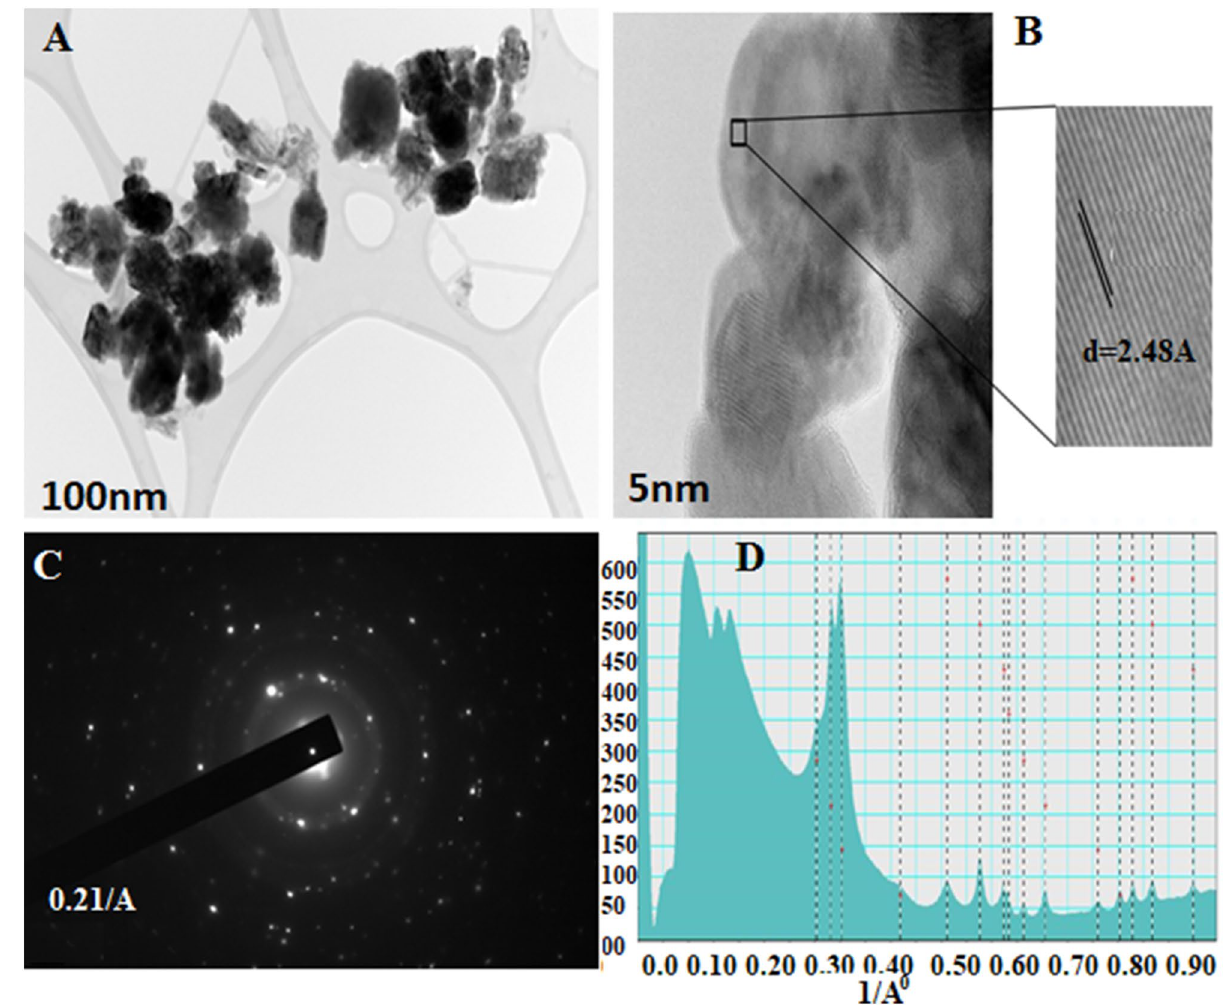
Figure 3. ( A ) Transmission electron microscopic and ( B ) High resolution-TEM images of ZnO NPs, ( C ) Selected area electron-diffraction outline of ZnO NPs, ( D ) Rotational average profile of Ω, Fig. 6(1B)). The decrease in R ct value confirms that the ZnO-NPs present in the composite improves the charge transfer characteristics of GN:ZnO NC modified GCE 42 . CC was applied to determine the electrochemi- cally active surface area of the GN and GN:ZnO NC modified electrodes by using Anson charge-time depend- ence equation Q = nFACD 1/2 π −1/2 t 1/2 , where ‘Q’ is charge in coulombs, ‘n’ number of electrons involved in redox reaction is 1 for K 3 [Fe(CN) 6 ] system, ’F’ Faraday Constant (96,485 Cmol −1 ), ‘A’ area of electrode in cm −2 , ‘C’ concentration of K 3 [Fe(CN) 6 ] (1 mM), ‘D’ diffusion coefficient is 7.6 × 10 −6 cm 2 s −1 for K 3 [Fe(CN) 6 ] and ’t’ is time in seconds [30]. The slope obtained from the plot of Q against t 1/2 using CC and 1 mM K 3 [Fe(CN) 6 ] standard complex was used to calculate the effective electrochemical surface areas for GN and GN:ZnO NC modified electrodes (Fig. S1A,B, supplementary material). Basd on the linear relationship between Q and t 1/2 , the slopes obtained for GN:ZnO NC/GCE and GN/GCE were found to be 138.40 Cs −1/2 and 76.44 Cs −1/2 , respectively (Fig. S1A,B). The effective electrochemical surface areas for GN:ZnO NC/GCE and GN/GCE were found to be 0.166 cm 2 and 0.092 cm 2 , respectively. Electrochemical performance of GN:ZnO NC modified GCE for p‑NP detrmination. Cyclic vol- tammetric (CV) study was carried out at a scan-rate of 100 mVs −1 to investigate the electrochemical behavior of 1.96 × 10 –6 M p-NP at bare GCE, GN/GCE, and GN:ZnO NC/GCE. Figure 6 (2a) is the CV of the blank contain- ing phosphate buffer at pH 6.8 at bare GCE. However, using bare-GCE at the same scan-rate and concentration of 1.96 × 10 –6 M, p-NP gives a weak redox couple at 0.20 V ascribed to p-NP (Fig. 2b), while the peak current progressively increased on GN modified GCE (Fig. 2c), and further enhanced with GN:ZnO NC modified GCE (Fig. 2d). Also, the irreversible reduction peak of p-NP at − 0.75 V grows progressively at both GN and GN:ZnO NC modified GCE. This shows that both ZnO NPs and GN had an electrocatalytic effect where ZnO NPs act as spacer to enhance the effective-surface area of GN and improve the electrochemical activity while GN decreases the resistance by providing a conducting path. Therefore, the synergic effect of ZnO NPs and GN as cocatalysts